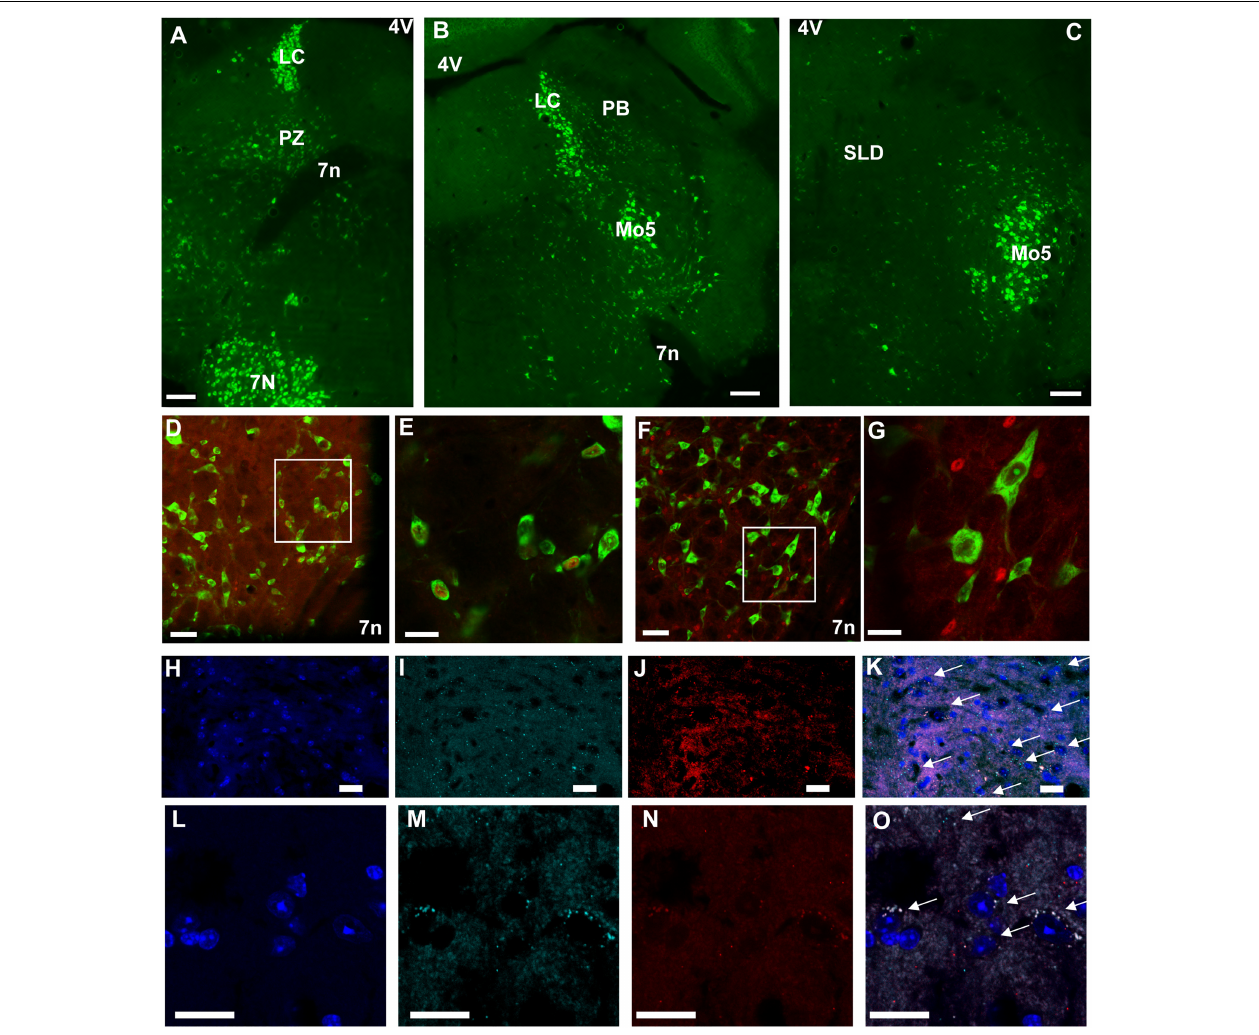
FIGURE 6 | Phox2B is expressed in PZ and is co-localized with Vglut2. (A–C) Images from a Phox2B-GFP mouse brain showing Phox2B-expressing neurons in PZ (A) but not in PB (B) or SLD (C) . Scale bar: 200 µ m. (D) Confocal images from PZ showing native GFP from a Vglut2-GFP mouse immunolabeled for Phox2B in red. Scale bar: 50 µ m. (E) Higher magnification of the box in (D) . Scale bar: 20 µ m. (F) Confocal images from PZ showing native GFP from a Vgat-GFP mouse immunolabeled for Phox2B in red. Scale bar: 50 µ m. (G) higher magnification of the box in (F) . Scale bar: 20 µ m. (H–O) Confocal images of the PZ showing DAPI staining of nuclei (H,L) , and mRNA of Vglut2 (I,M) and Phox2B (J,N) from two mice. The merged images show complete overlap of both mRNA expression (arrows in K , O ). Scale bar: 20 µ m. Abbreviations: 4 V, fourth ventricle; 7 n, seventh facial nerve; LC, locus coeruleus; Mo5, motor trigeminal nucleus; PB, parabrachial nucleus; PZ, parafacial zone; SLD, sublaterodorsal